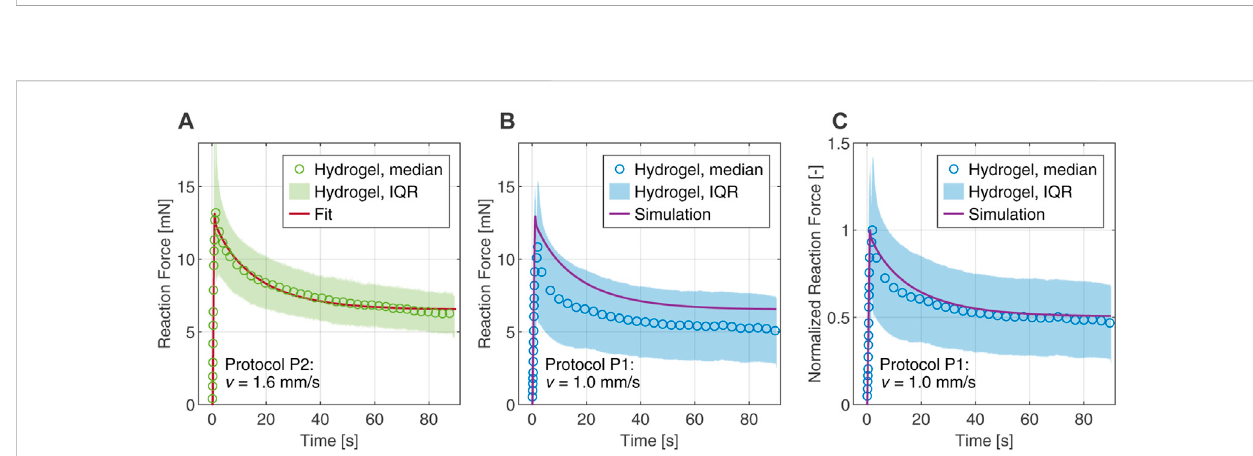
FIGURE 6 Comparison between computational and experimental results in the fi rst indentation cycle of the composite hydrogel. The experimental data are represented by the median and interquartile range (IQR). (A) Fitted reaction force of protocol P2 obtained from the inverse parameter identi fi cation scheme. (B) Numerical simulation of protocol P1 with material parameters determined from the fi t. (C) Reaction force of protocol P1 normalized by the peak forces, comparing experiment and